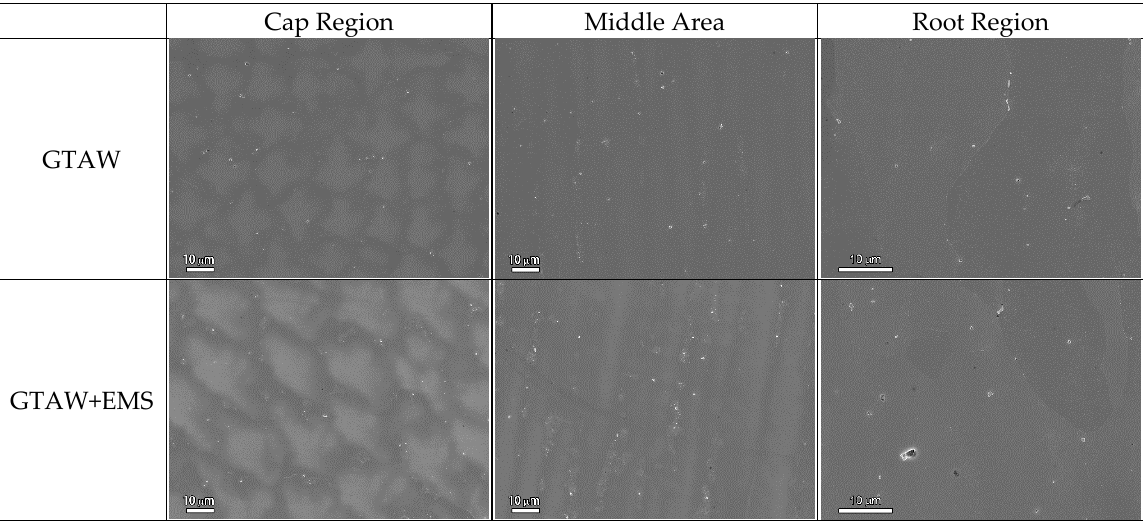
Figure 10. SEM micrographs of Alloy 52M.